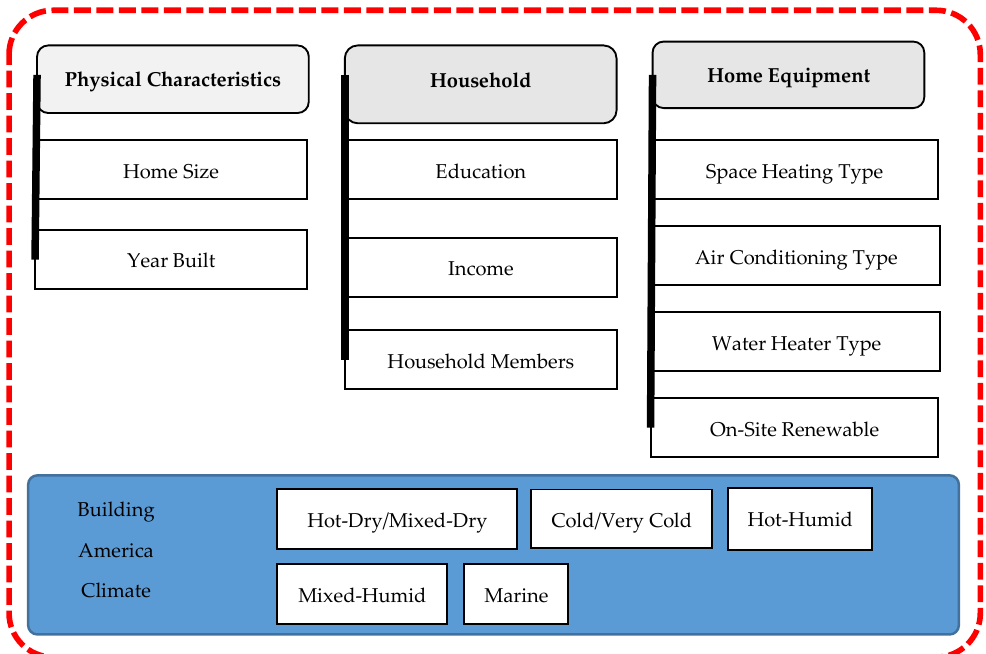
Figure 1. Proposed conceptual framework.